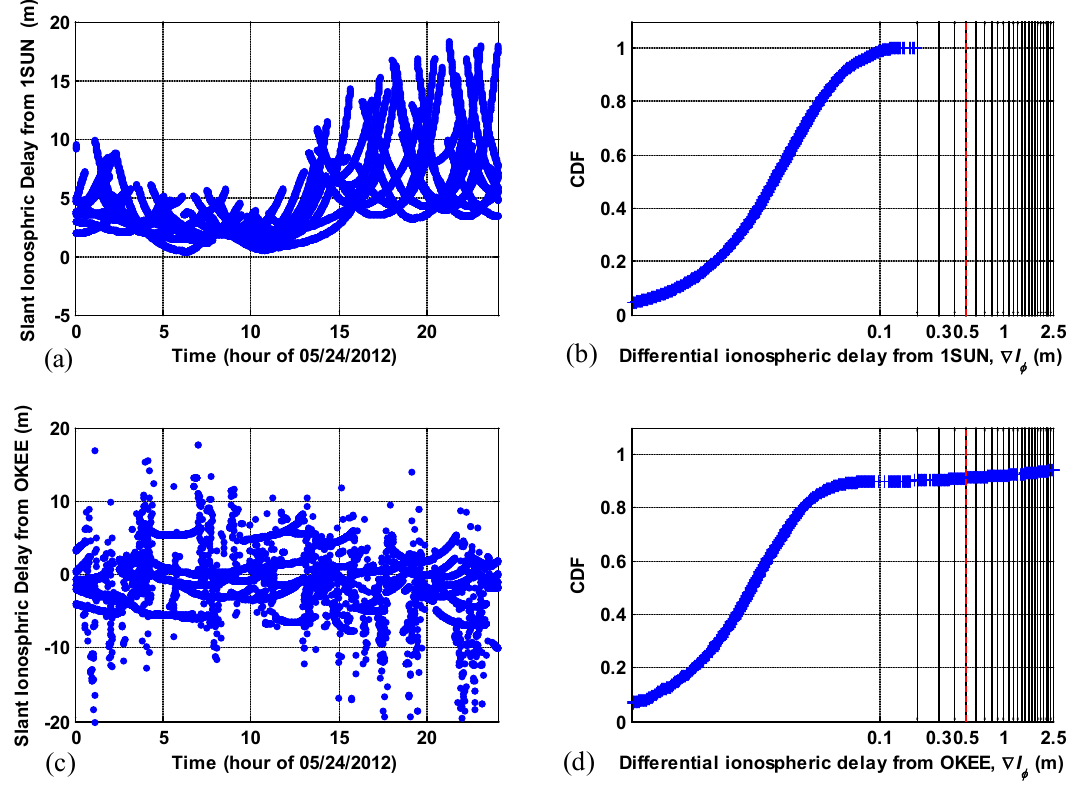
( a ) dual-Frequency slant ionospheric delay estimates to all satellites for CORS station 1SUN (good quality data); ( b ) cumulative distribution function of differential ionosheric ∇ , for 1SUN; ( c ) slant ionospheric delay estimates for CORS station OKEE delay, I φ (poor quality data); and ( d ) cumulative distribution function of differential ionosheric delay for